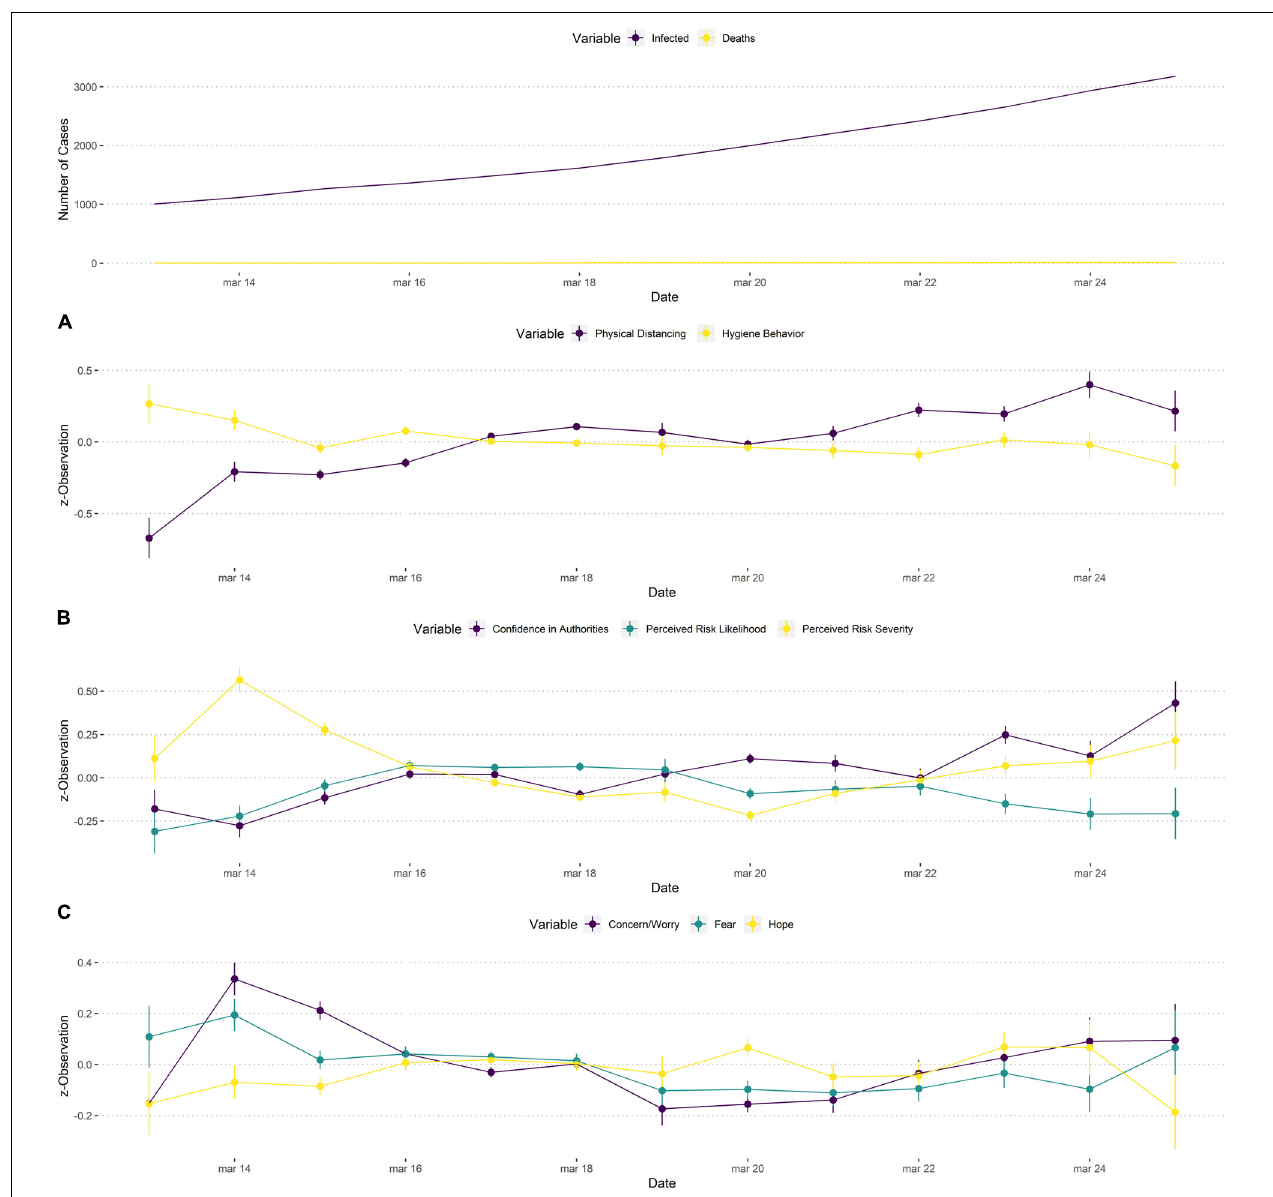
FIGURE 4 | Time series of behavior (A) , attitudes (B) , and affective reactions (C) from the 13th until the 25th of March. All variables are z-standardized to ease comparisons. Error bars represent standard errors. The first row shows number of total infected cases and deaths per day based on data by the